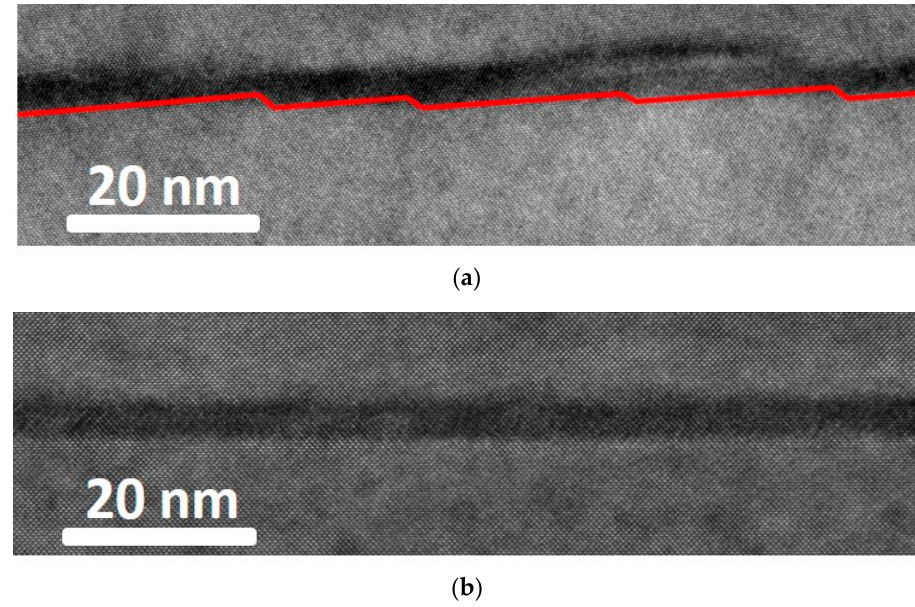
Figure 3. Cross-section of images in the [1–10] zone of the In 0.4 Ga 0.6 As QWD layers grown on ( a ) vicinal and ( b ) exact-oriented GaAs substrates.